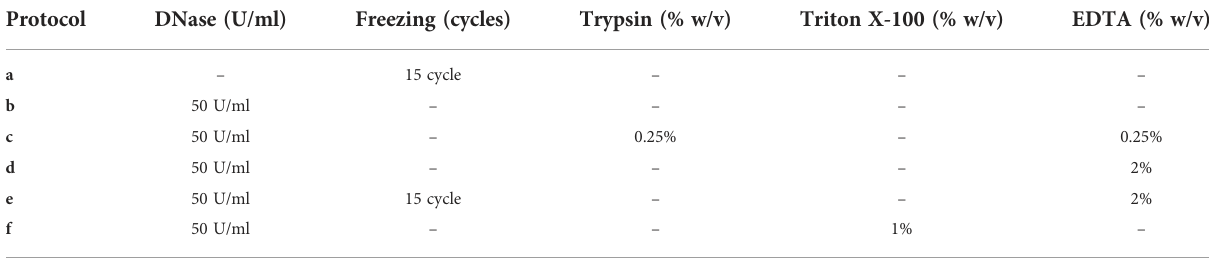
TABLE 2 Treatment type and concentrations used in each one of the decellularization protocols. Protocol